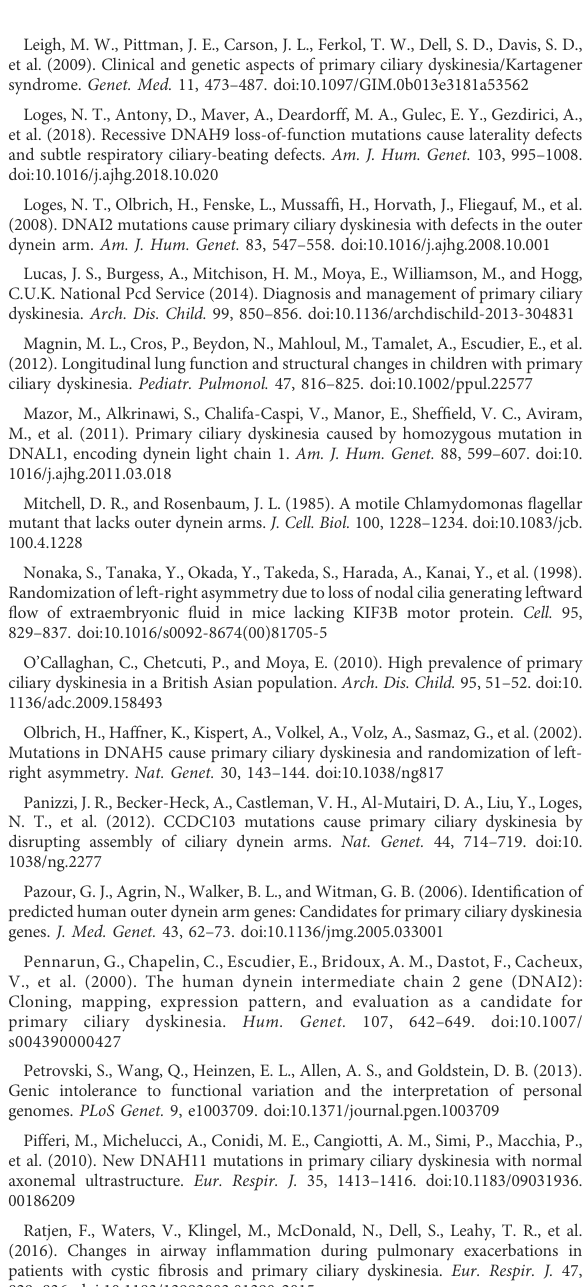
SUPPLEMENTARY FIGURE S2 Immuno fl uorescence images of primary respiratory epithelial cells for PCD patients. The IF was performed using monoclonal anti-acetylated α tubulin: panel (A) and polyclonal anti- DNAH5: panel (B) antibody for selected PCD patients versus healthy controls. As seen in the control, the merged images: panel (C) show a yellow co-staining within the ciliary axoneme which indicates that both proteins co-localized within respiratory cilia compared with the images for PCD patients that demonstrate an absence of anti-DNAI2 staining. Scale bar is 10 µm: panel (D) .